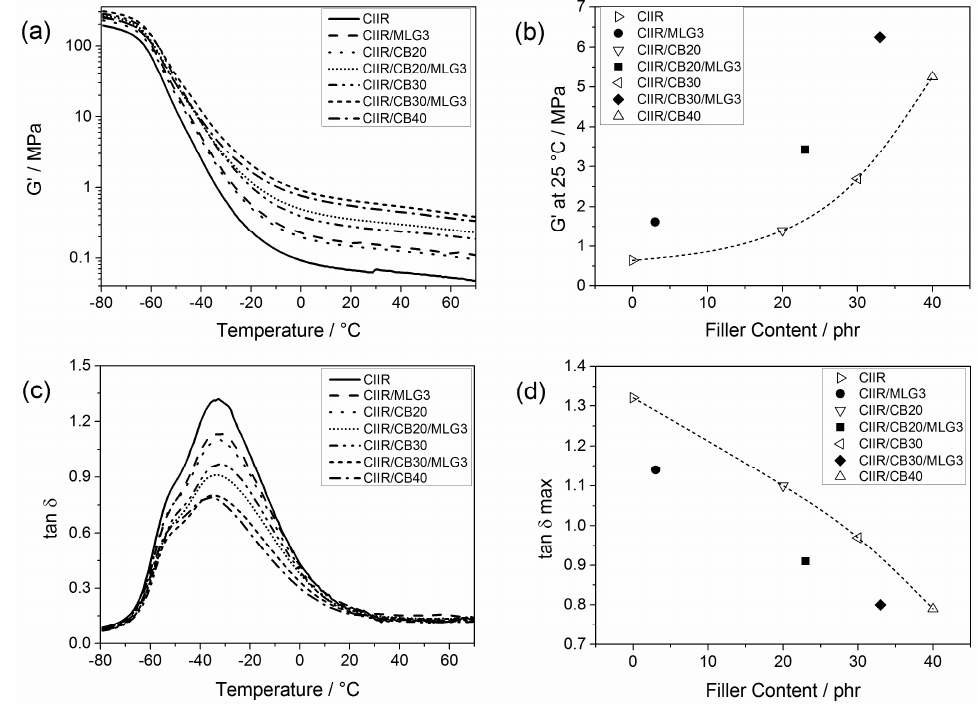
Figure 12. ( a ) Storage modulus of CIIR and its composites as a function of the temperature; ( b ) storage modulus at 25 °C as a function of the filler content—the line is a visual guide; ( c ) tan δ of CIIR and its composites as a function of temperature; and ( d ) maximum of tan η as a function of the filler content—the line is a visual guide.